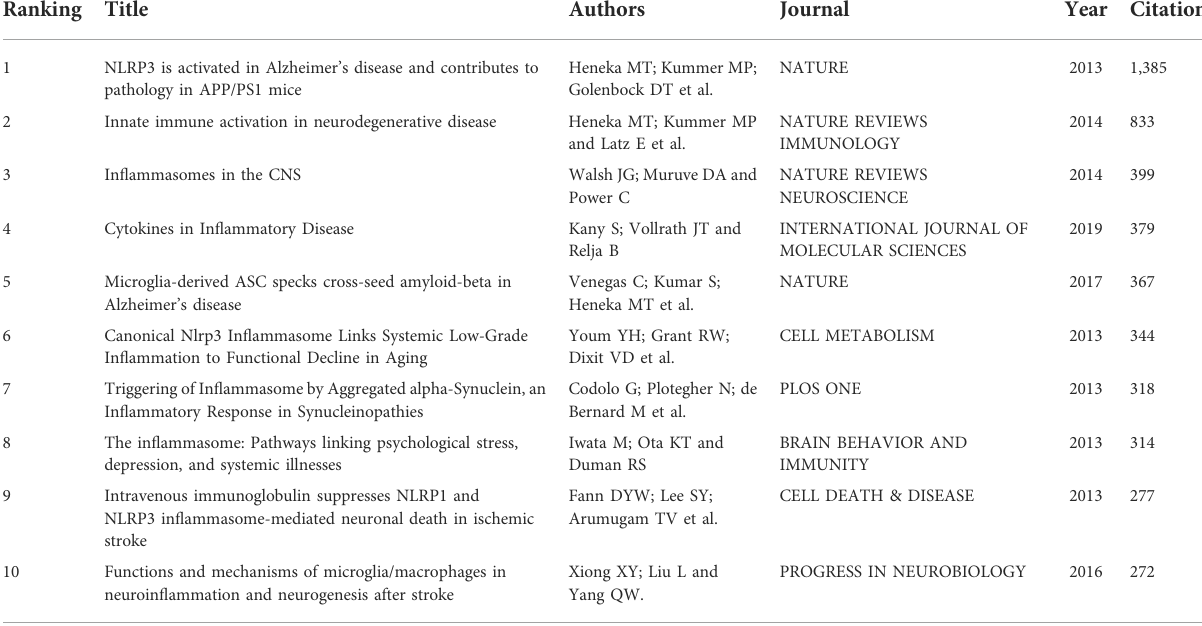
TABLE 4 Top 10 high-cited references related to NLRP3 in fl ammasome in neurological